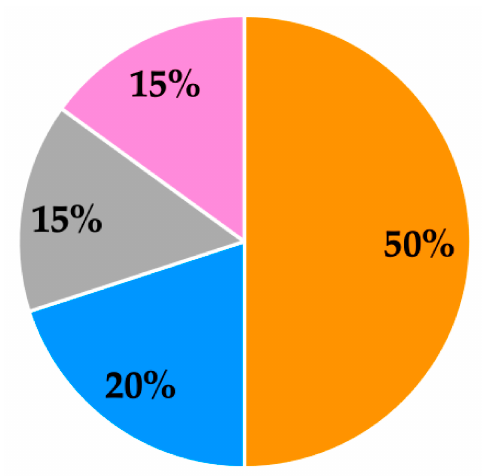
Figure 2. Overview of whey protein typical percentage composition [76] (minor components of whey protein are bovine serum albumin (BSA), immunoglobulins, lactoferrin and